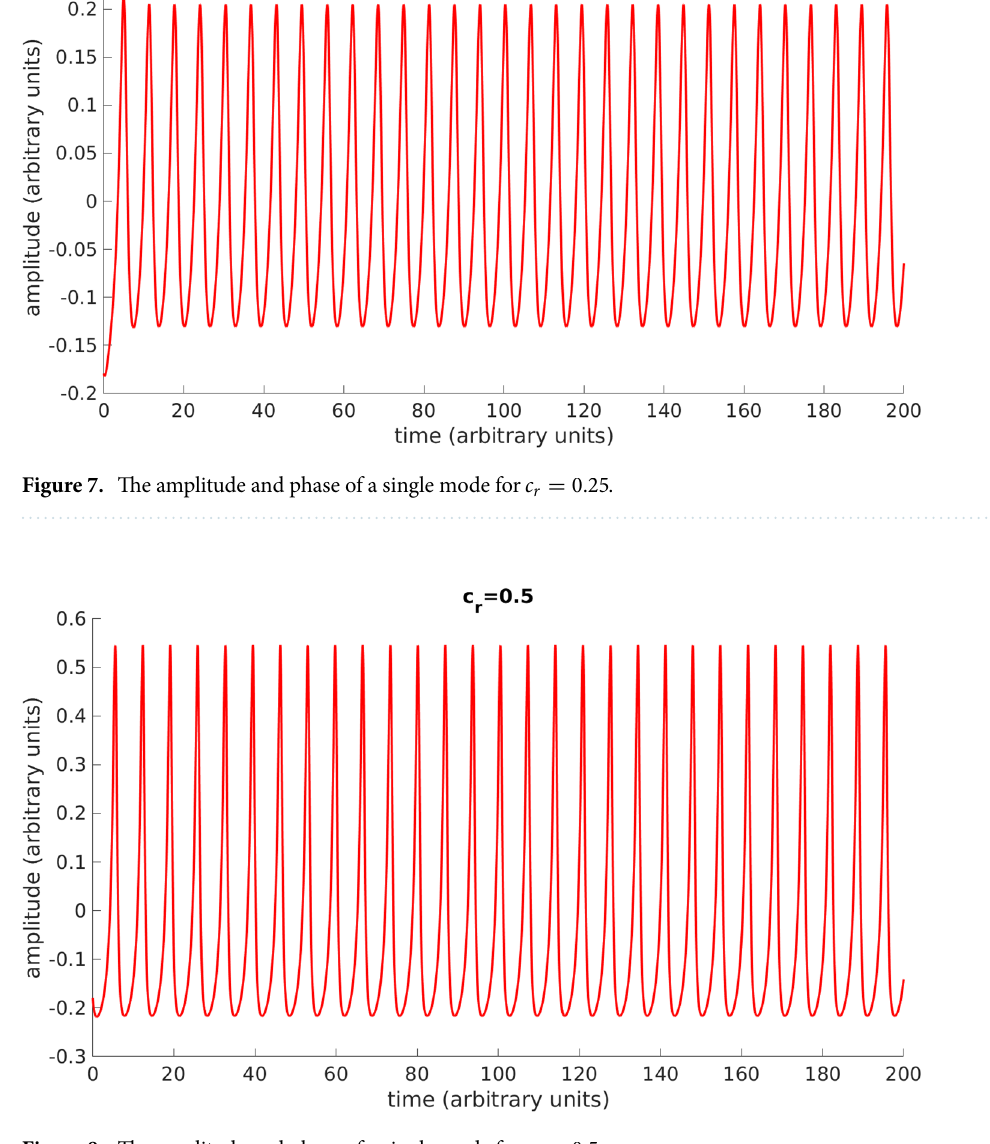
Figure 8. The amplitude and phase of a single mode for c r = 0.5